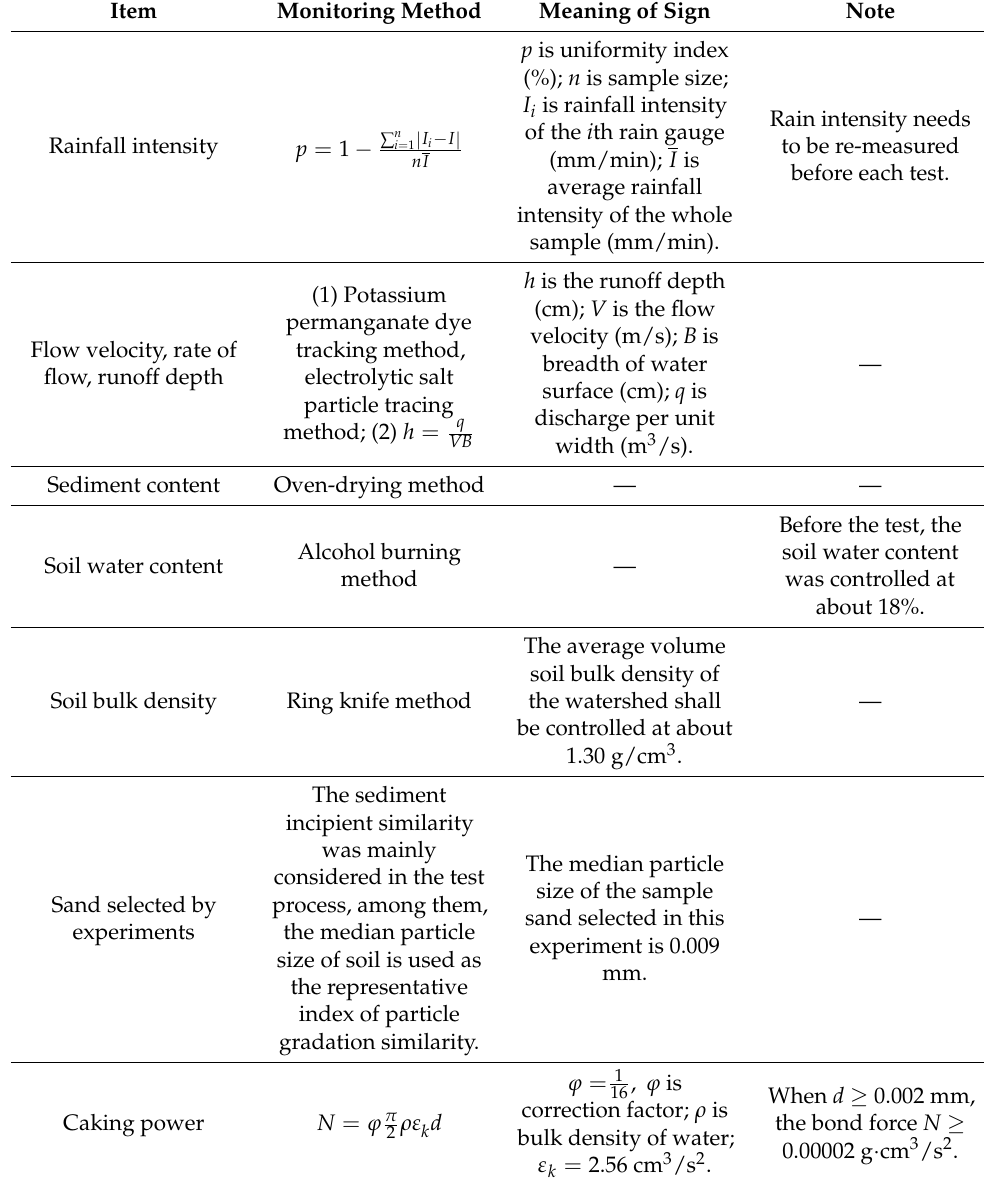
Table 4. Monitoring method of each monitoring index.